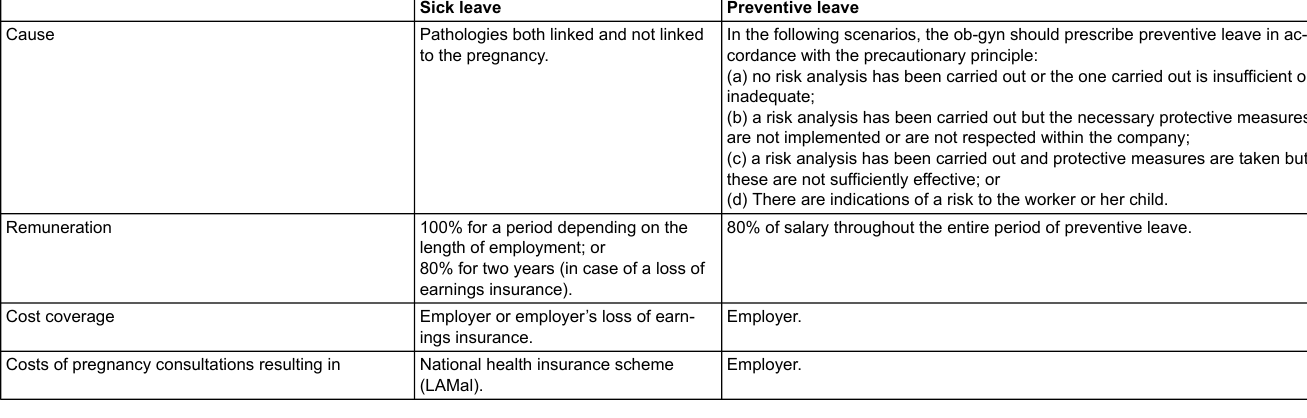
Table 3: Comparison between sick leave and preventive leave of pregnant employees in